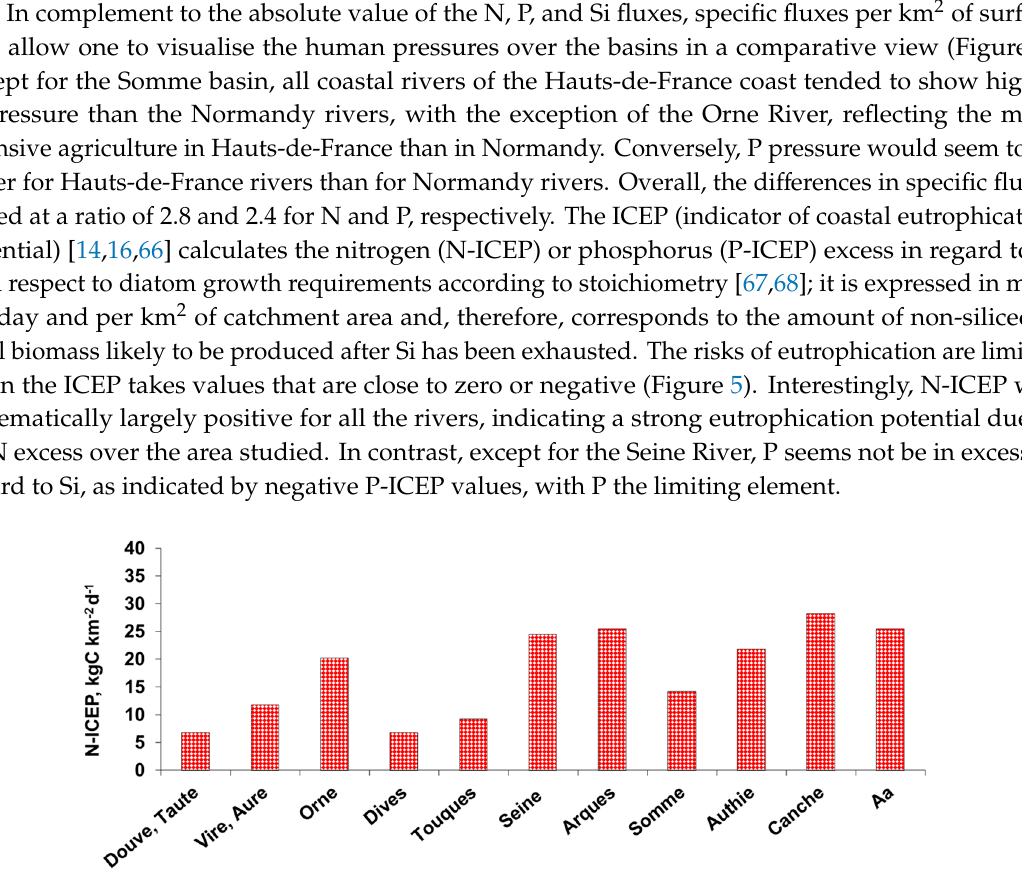
Figure 5. Indicator of coastal eutrophication potential for N and P (N-ICEP-N and P-ICEP; kg C km − 2 y − 1 ) for the rivers studied and averaged for the 2002–2014 period.